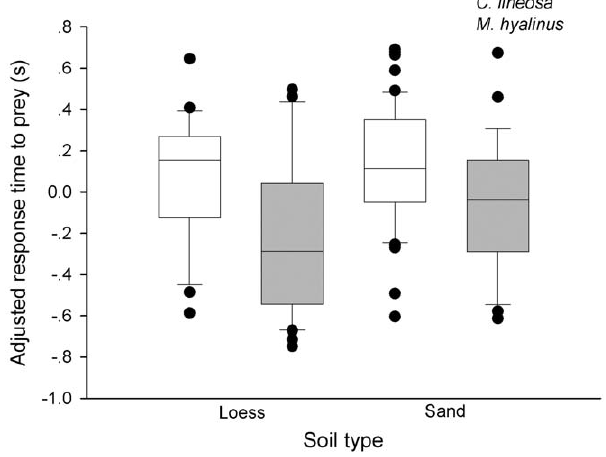
Figure 3. Time to pit construction of antlions. M. hyalinus larvae constructed pits faster than C. lineosa larvae, irrespective of the soil type. Key: median (horizontal lines in boxes), inter-quartile range (boxes), 95th and 5th percentiles (vertical bars), outliers (black dots).